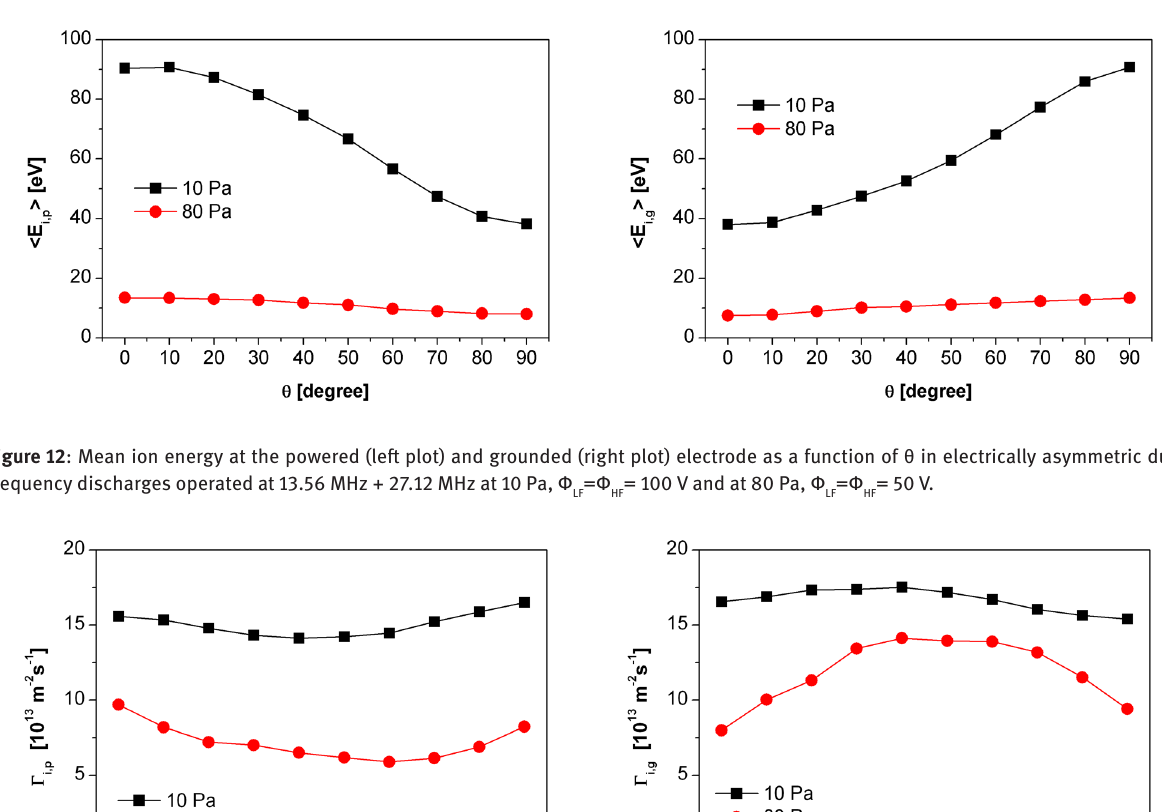
Figure 13 : Ion flux at the powered (left plot) and grounded (right plot) electrode as a function of θ in electrically asymmetric dual-frequency discharges operated at 13.56 MHz + 27.12 MHz at 10 Pa, Φ